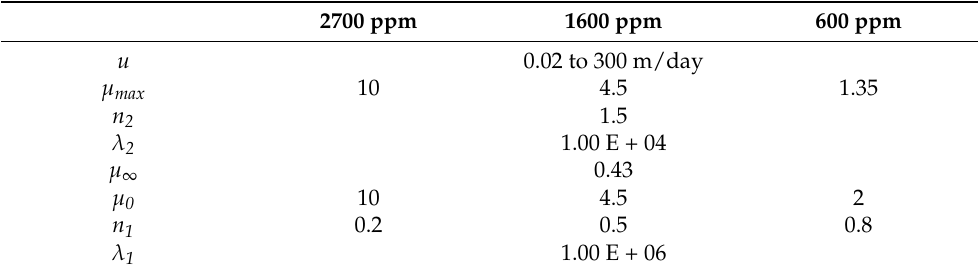
Table 3. Parameters used to generate in situ rheology curves for sensitivity tests.